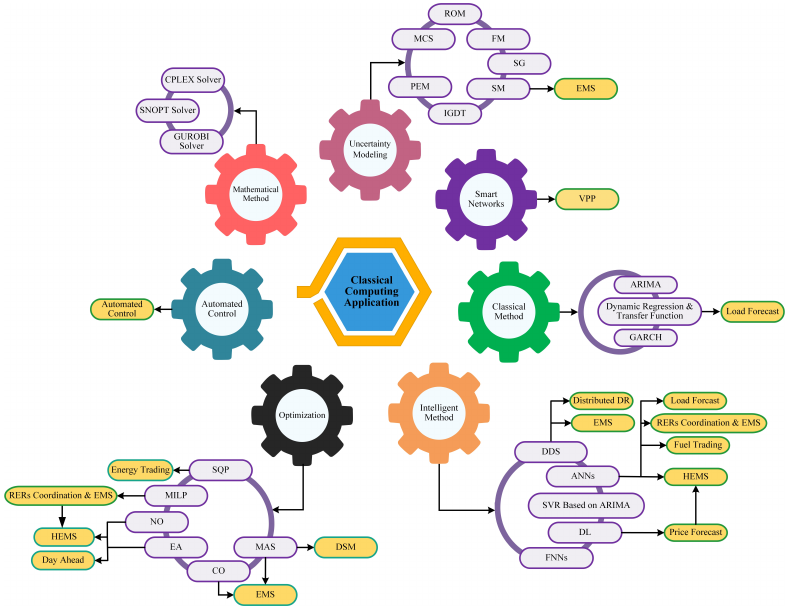
Figure 7. Application of classical computing